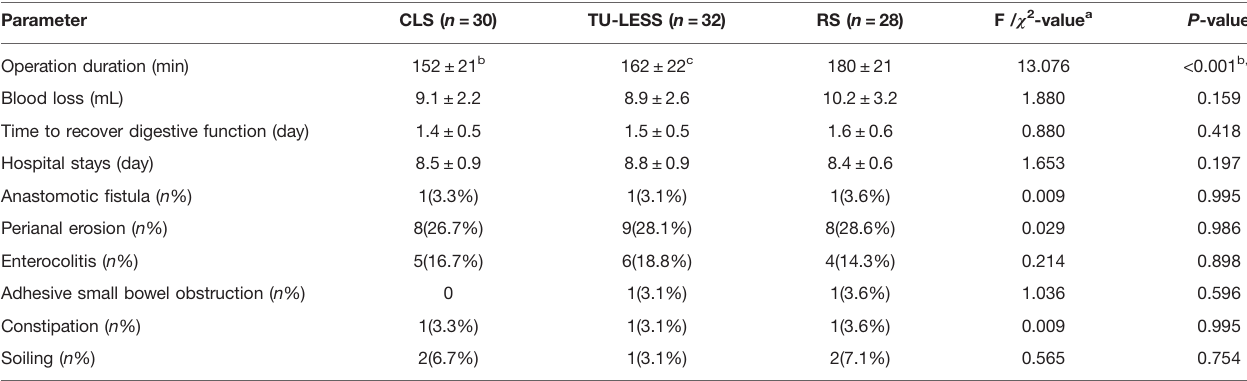
TABLE 2 | Perioperative data and postoperative follow-up